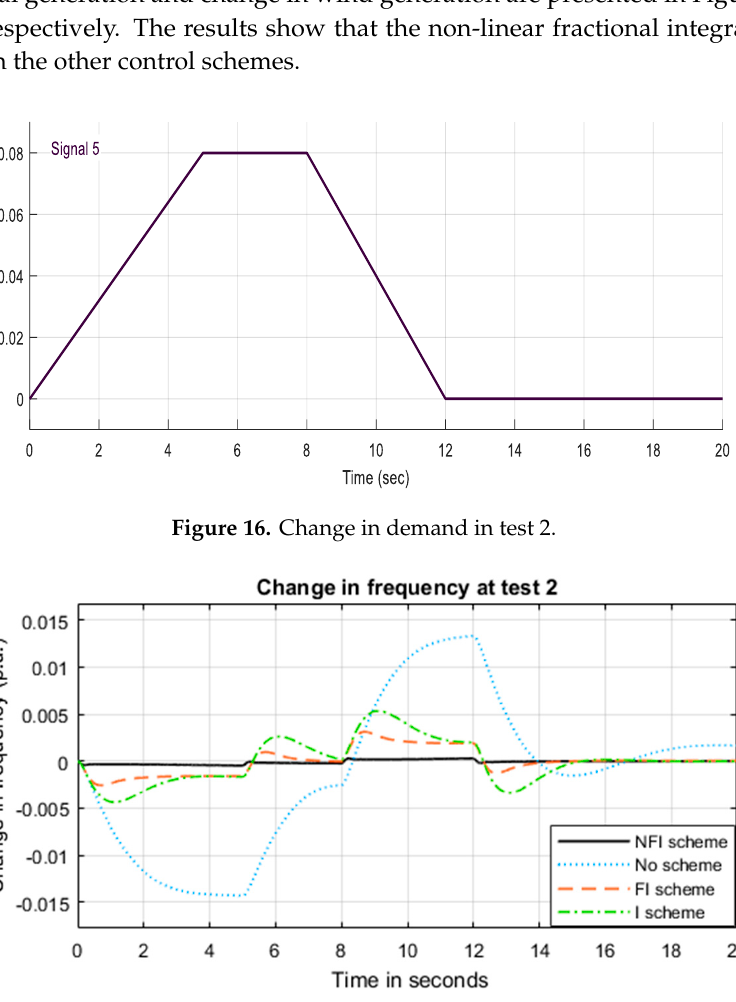
Figure 18. Change in tidal power in test 2. Figure 19. Change in wind power in test 2. 5.3. System Performance under Test 3 In this test, the wave system has sinusoidal power variation as expressed in the following equation [12,13].